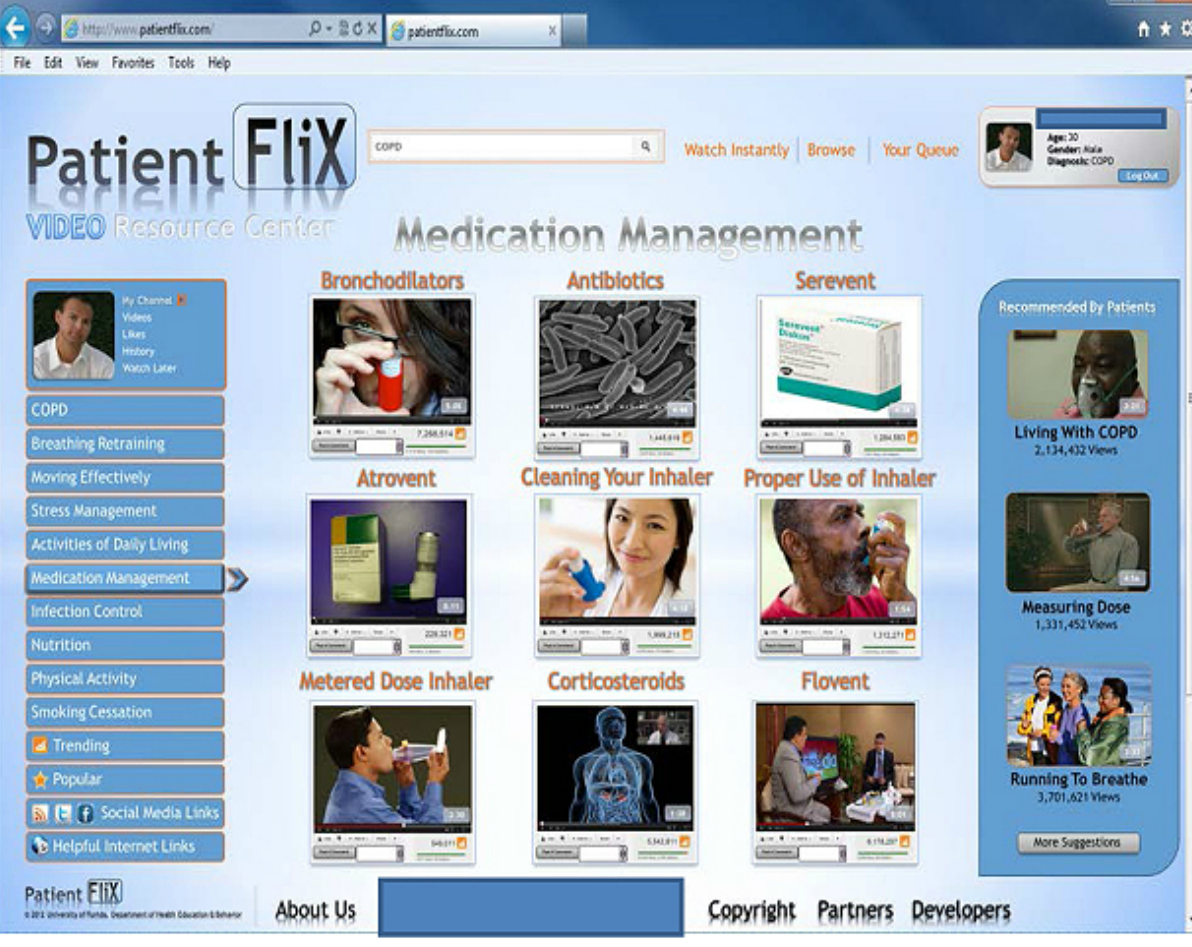
Figure 1. Original mock-up of the online COPD patient education social media